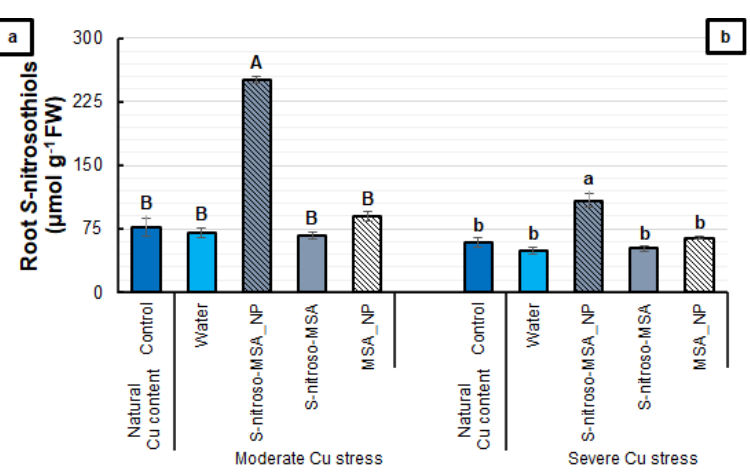
Figure 6. Root S-nitrosothiol content ( a , b ) of soybean plants cultivated in soil containing different copper (Cu) levels (natural content: 11 mg kg − 1 ; moderate Cu stress: 164 mg kg − 1 ; severe Cu stress: 244 mg kg − 1 ). Control = treatment with distilled water; water = treatment with distilled water after Cu addition; S-nitroso-MSA_NP = treatment with a nanoencapsulated NO donor (S-nitroso-mer- captosuccinic acid) at 1 mM; S-nitroso-MSA = treatment with a NO donor (S-nitroso-mercaptosuc- cinic acid) in the free form at 1 mM; MSA_NP = treatment with nanoparticles containing the non- nitrosated MSA at 1 mM. Data are the mean ± standard error ( n = 4). The same uppercase and low- ercase letters on the column (referring to experiments 1 and 2, respectively) indicate values that do not differ by ANOVA, followed by the Tukey test ( p < 0.05). Regarding the parameters that indicate the occurrence of oxidative stress, Figure 7a,c shows that the tested formulations did not affect the root H 2 O 2 and CD levels, compared to the water treatment under moderate Cu stress. In contrast, under severe Cu stress, it was possible to verify an increase in H 2 O 2 content in the water (107%) and MSA_NP (53%) treatments (compared to the control), which was prevented by S-nitroso-MSA_NP and S- nitroso-MSA (Figure 7b). For CD, S-nitroso-MSA_NP was the only treatment that pre- vented the Cu-induced increase in this marker of oxidative stress (Figure 7d).